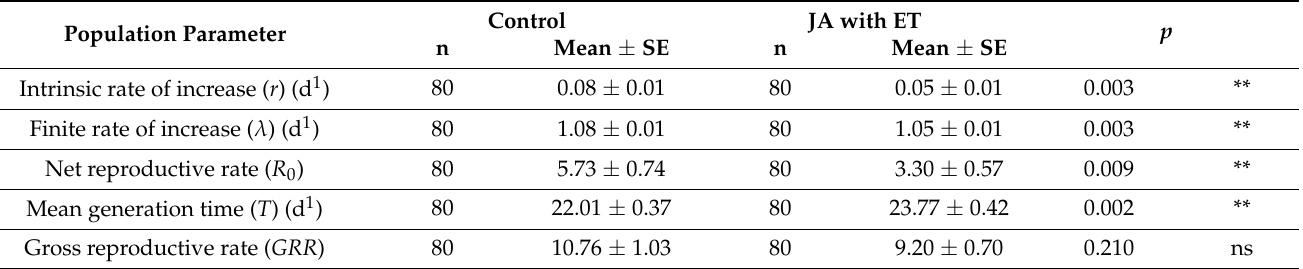
Table 3. Effect of the JA with ET treatment on the population parameters of offspring of Frankliniella occidentalis grown on faba bean